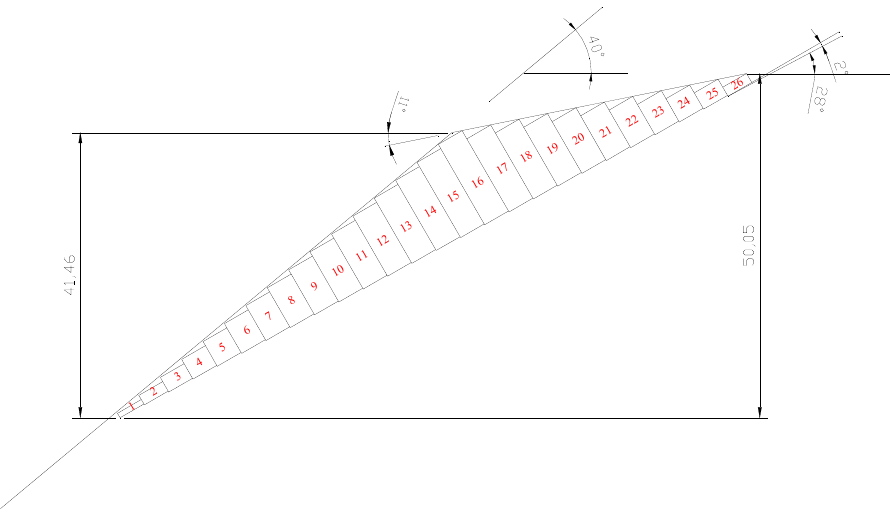
Figure 7. The limit equilibrium model for physical model on the shake table test